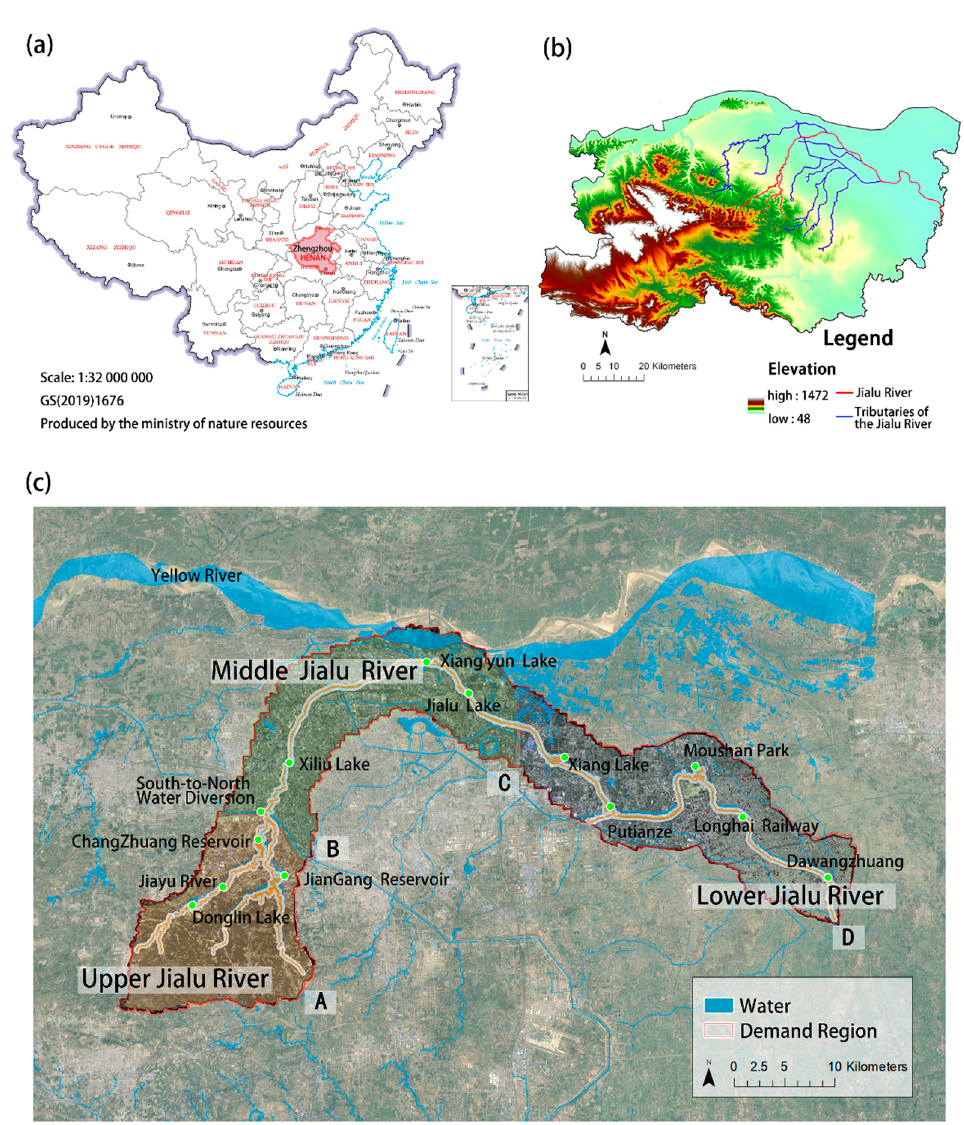
Figure 1. ( a ) Location of Zhengzhou, Henan Province, in China; gray lines indicated the boundaries of provinces and territories. ( b ) Location of Greater Zhengzhou with elevations; red lines indicate the Jialu River, and blue lines indicate the tributaries of the Jialu River. ( c ) Satellite image of Jialu river system; the area within the red polygon is the demand region, point A indicates the origin of the Jialu river watershed, point B indicates the South-to-North Water Diversion Project points, point C indicates eastern boundary of built-up area of Zhengzhou, and point D indicates the eastern boundary of Greater Zhengzhou.